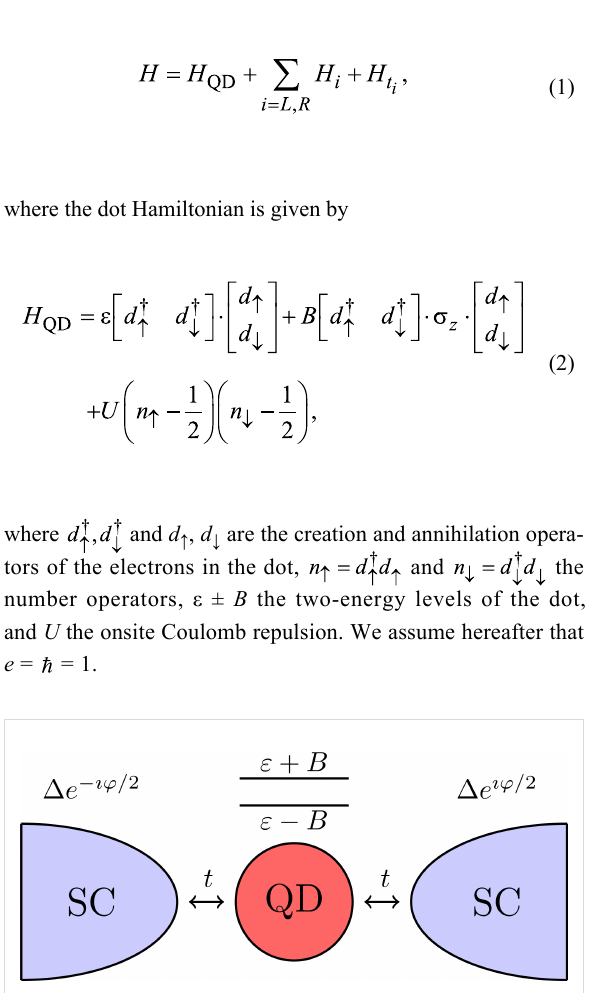
Figure 1. We assume that the only effect of the magnetic field is the lifting of the spin degeneracy via the Zeeman effect, and we neglect orbital effects of the field. Moreover, we assume that the level spacing of the dot is larger than the Zeeman energy B and larger than the Coulomb interaction U within the dot.